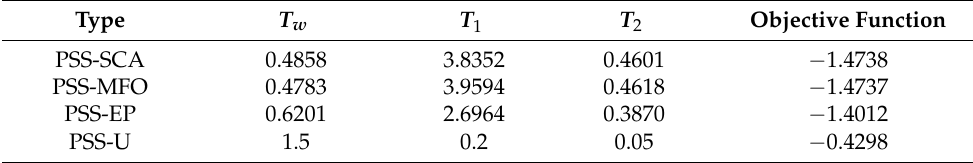
Table 5. Comparison of PSS-SCA, PSS-MFO, PSS-EP and PSS-U for Case